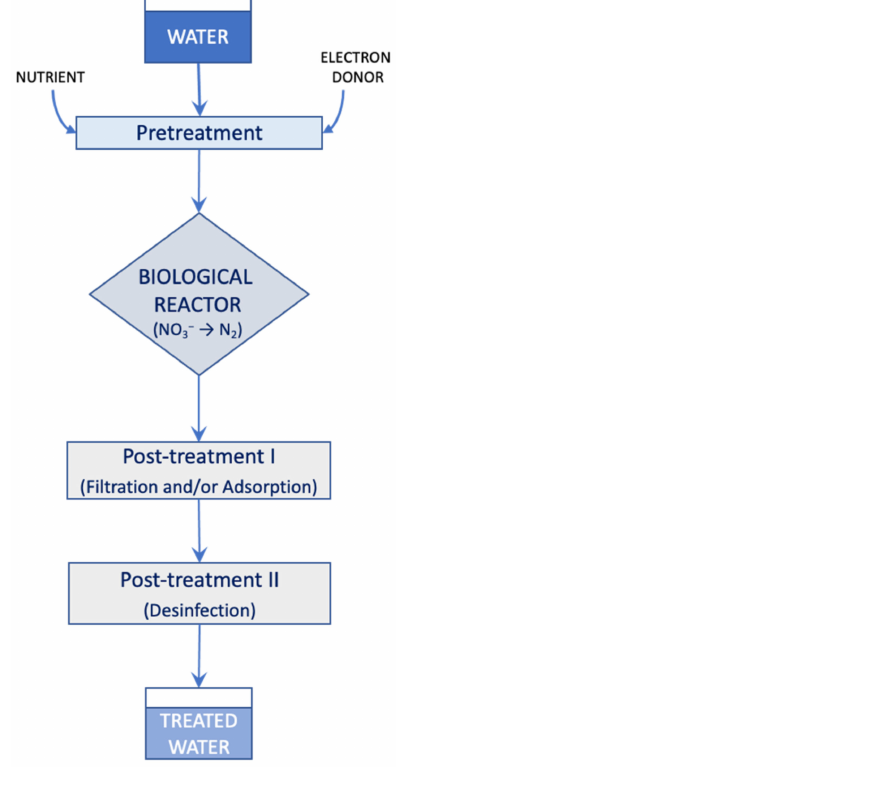
Figure 6. Flowchart representing a typical biological denitrification process (adapted from